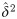
Application to experimental data from the MCF-7 pulse labeling time course experiment.A: We plot the diagonal term of the FIM computated at estimated parameter values and multiplied by δ^2, Iδδ(θ)δ^2, to illustrate contributions from labeled and unlabeled fractions to estimations of degradation rates for different experimental points (MCF-7 experiment, 2, 4, and 8 hr) and fractions (labeled and unlabeled). The black lines are the limiting values for the Iδδ(θ) according to Eq 20. B: The modified FIM term Iδδ(θ)δ^2 is computed for a range of labeling times for one of the fastest (at the 0.1% quantile) and one of the slowest (at the 99,9% quantile) genes (δfast = 0.79hr−1, δslow = 0.019hr−1). The normalization coefficient for the labeled and unlabeled fractions is adjusted in such a way that their sequencing depth (total mean read count) at time t equals the sequencing depth of the total sample.